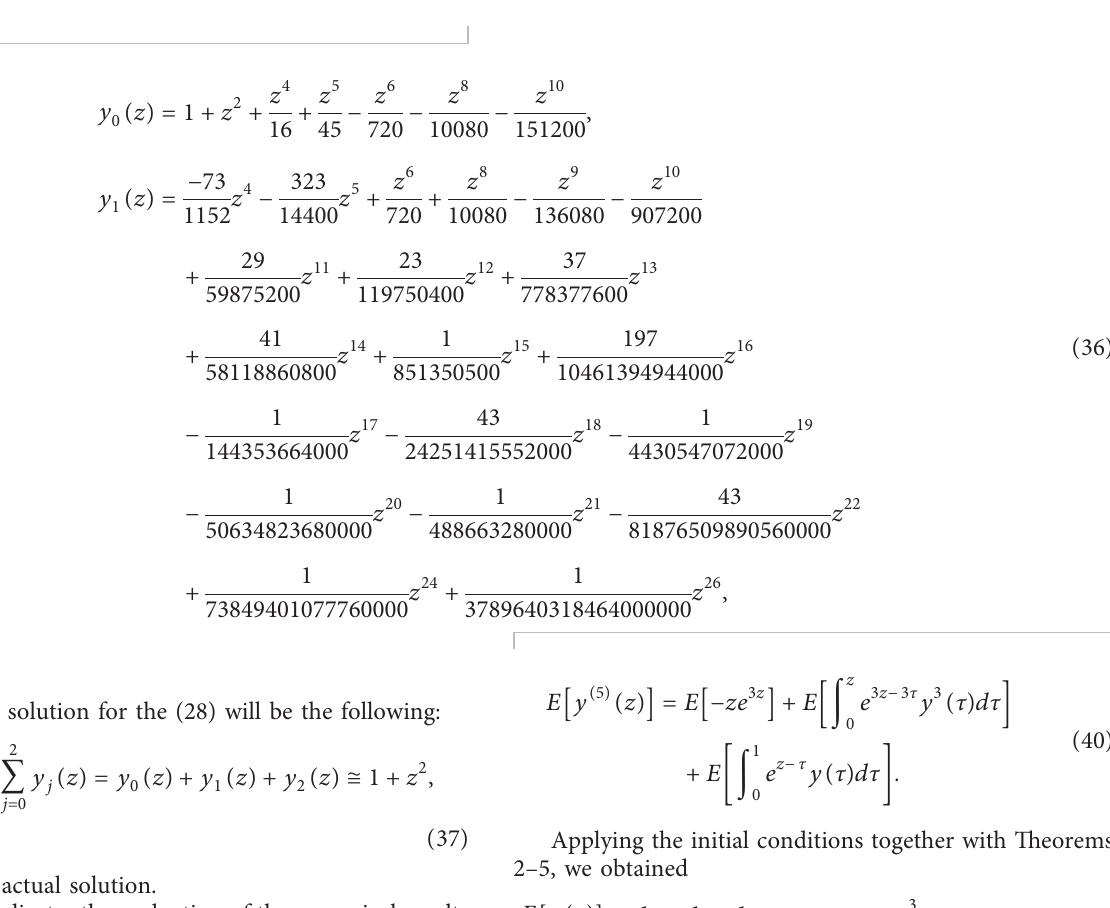
Table 2 indicates the evaluation of the numerical results and the exact solution, where the numerical solution exactly corresponds to the exact values as shown in Figure